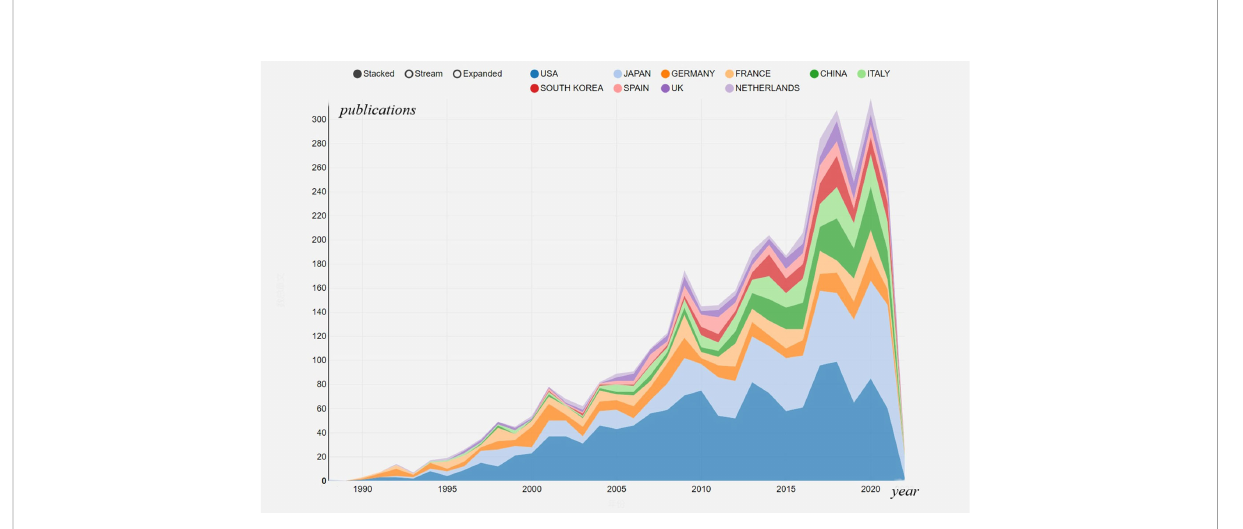
FIGURE 3 The contributions of different countries/regions to the research fi